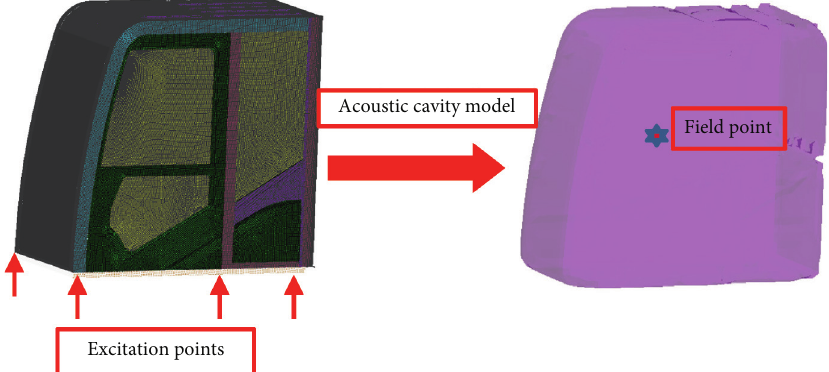
Figure 5: Cab vibroacoustic coupling